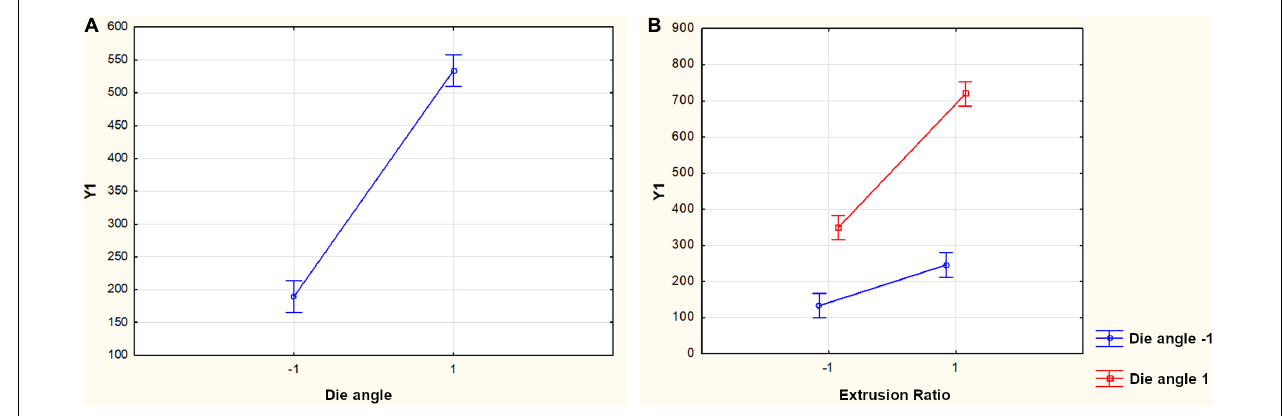
FIGURE 5 | (A) Main effect (X 5 ) with respect to Y1 and (B) interaction effect (X1X5) with respect to Y1. Vertical bars denote 0.95 confidence